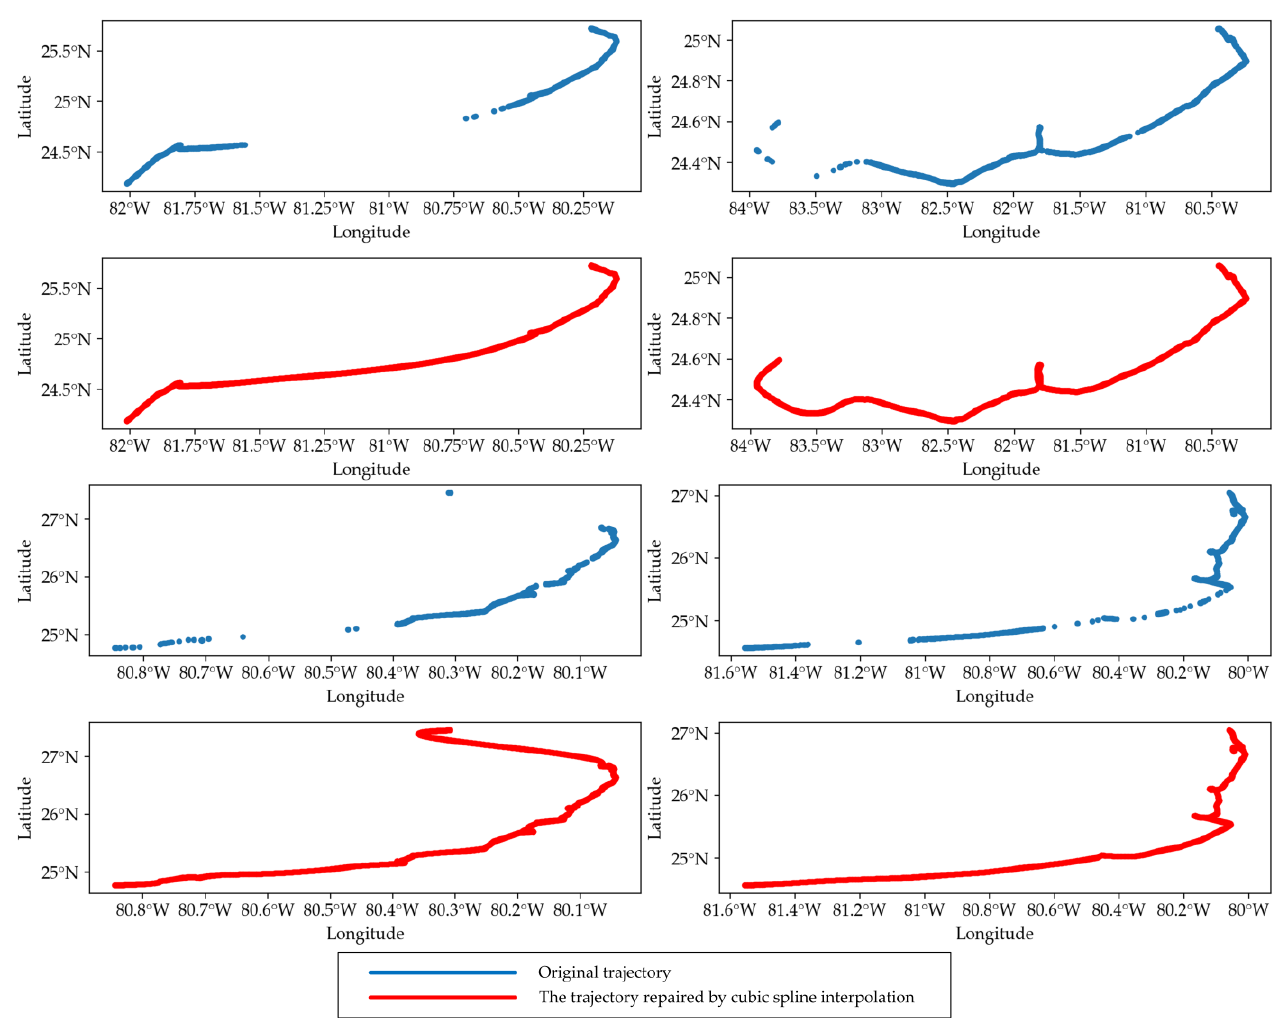
Figure 8. Trajectory repaired by cubic spline interpolation.